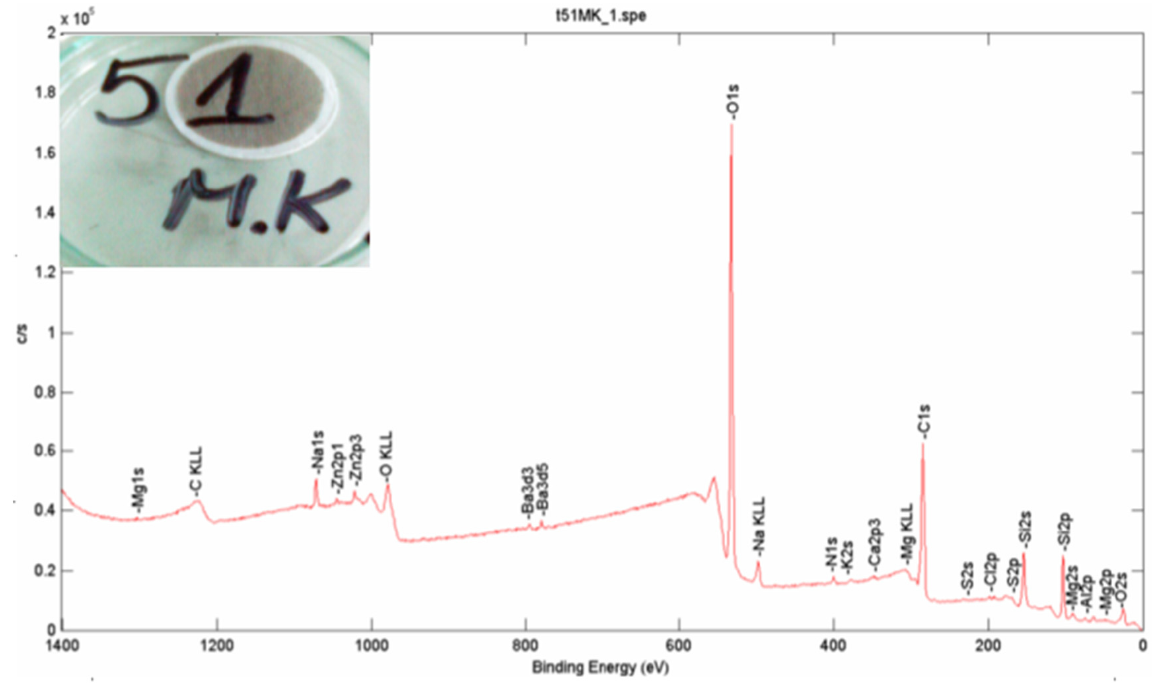
Figure 4. Example of the XPS spectrum in the energy range 0–1400 eV for the PM 4 in the apartment without smokers in Katowice.